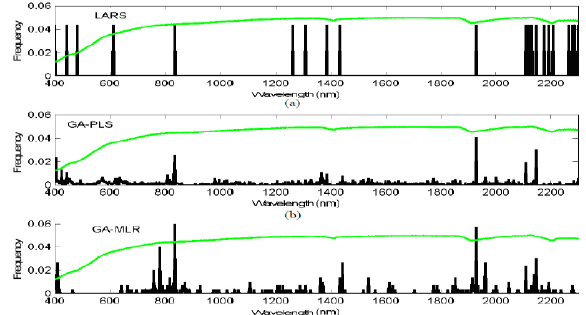
Figure 1 Comparison between three prediction methods using appropriate bands selections for the determination of soil lead content. The curve represents one typical soil reflectance spectrum (Zhang et al., 2010) .